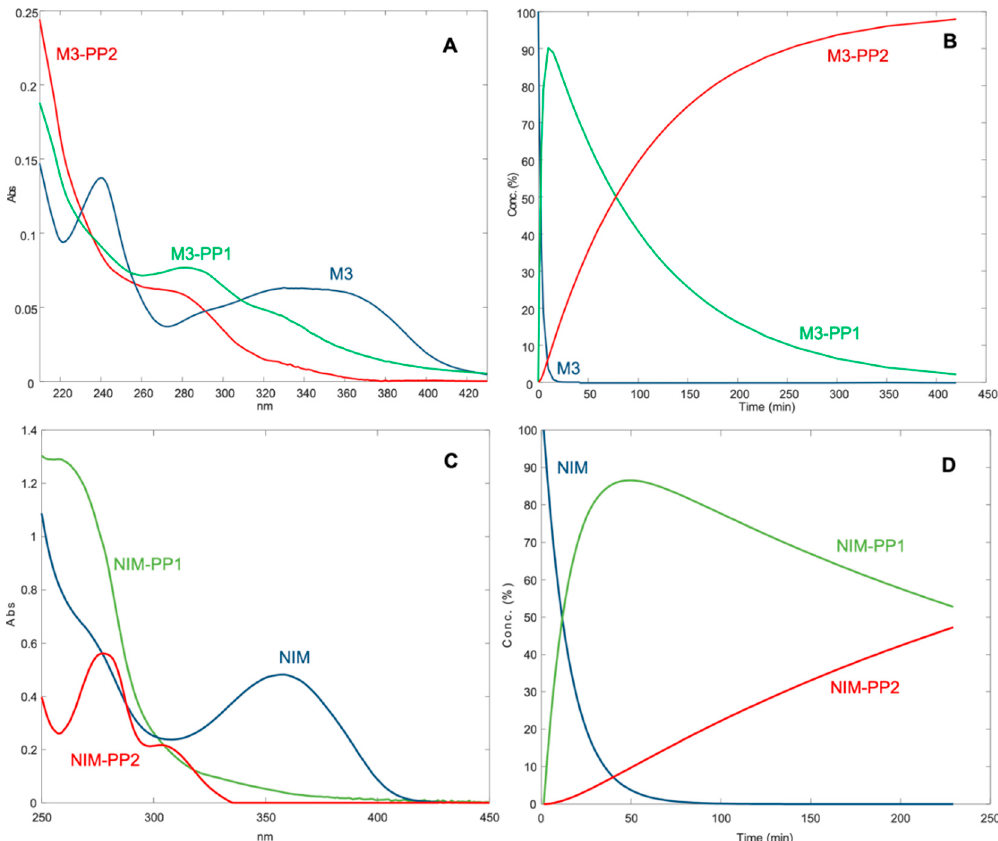
Figure 3. Spectra ( A ) and concentration profiles ( B ) for M3 and its photoproducts; spectra ( C ) and concentration profiles ( D ) for NIM and its photoproducts.